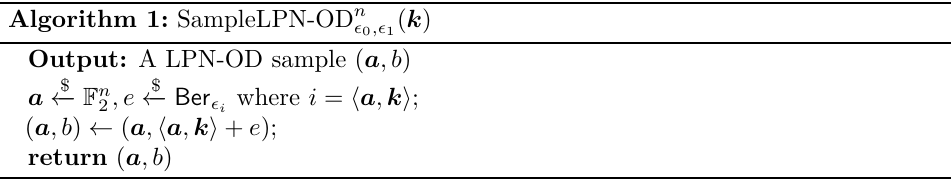
Algorithm 2: AltSampleLPN-OD n